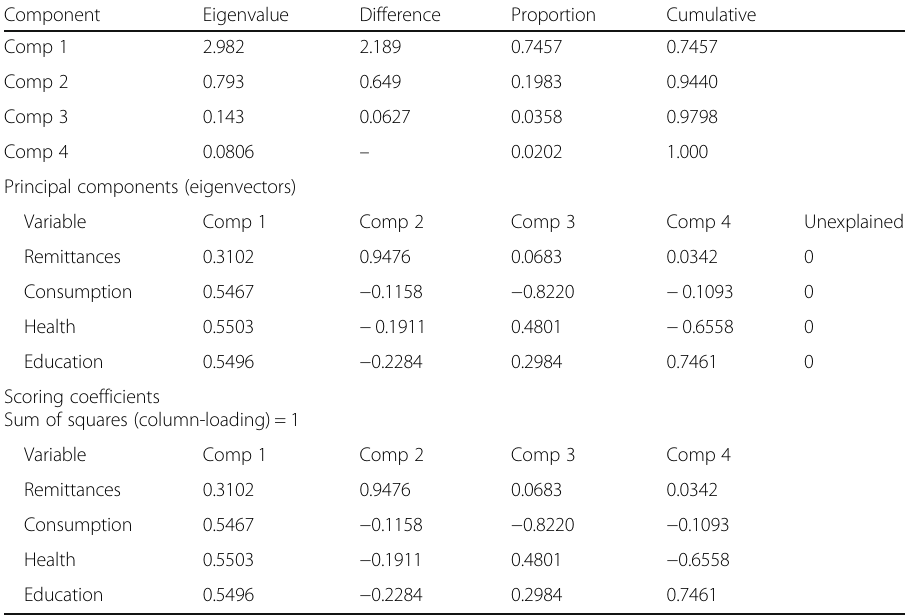
Table 6 Principal component analysis results for Human Economic Welfare Enhancement (HEWE)